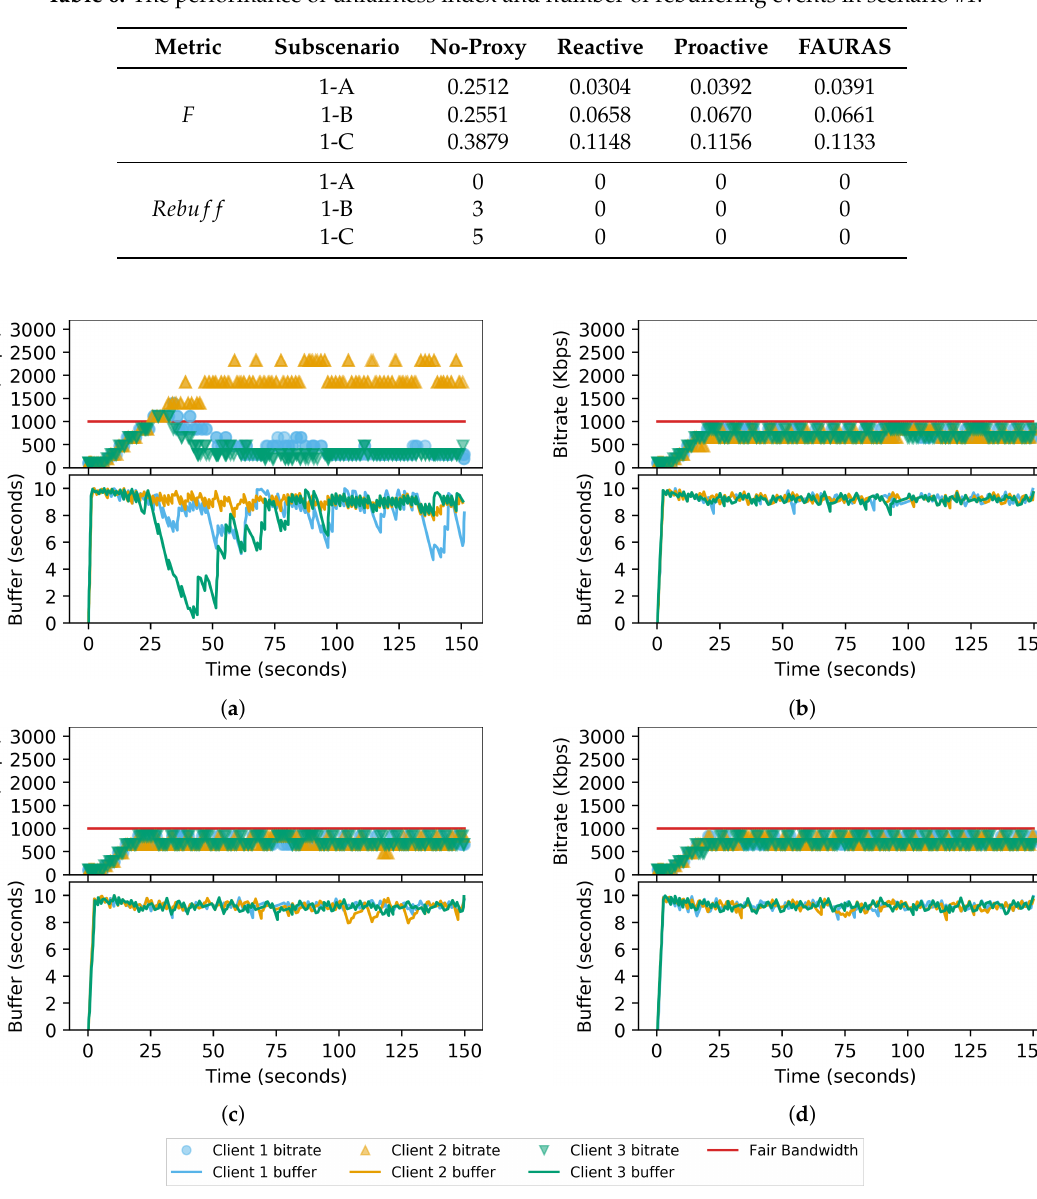
Table 6. The performance of unfairness index and number of rebuffering events in scenario #1.